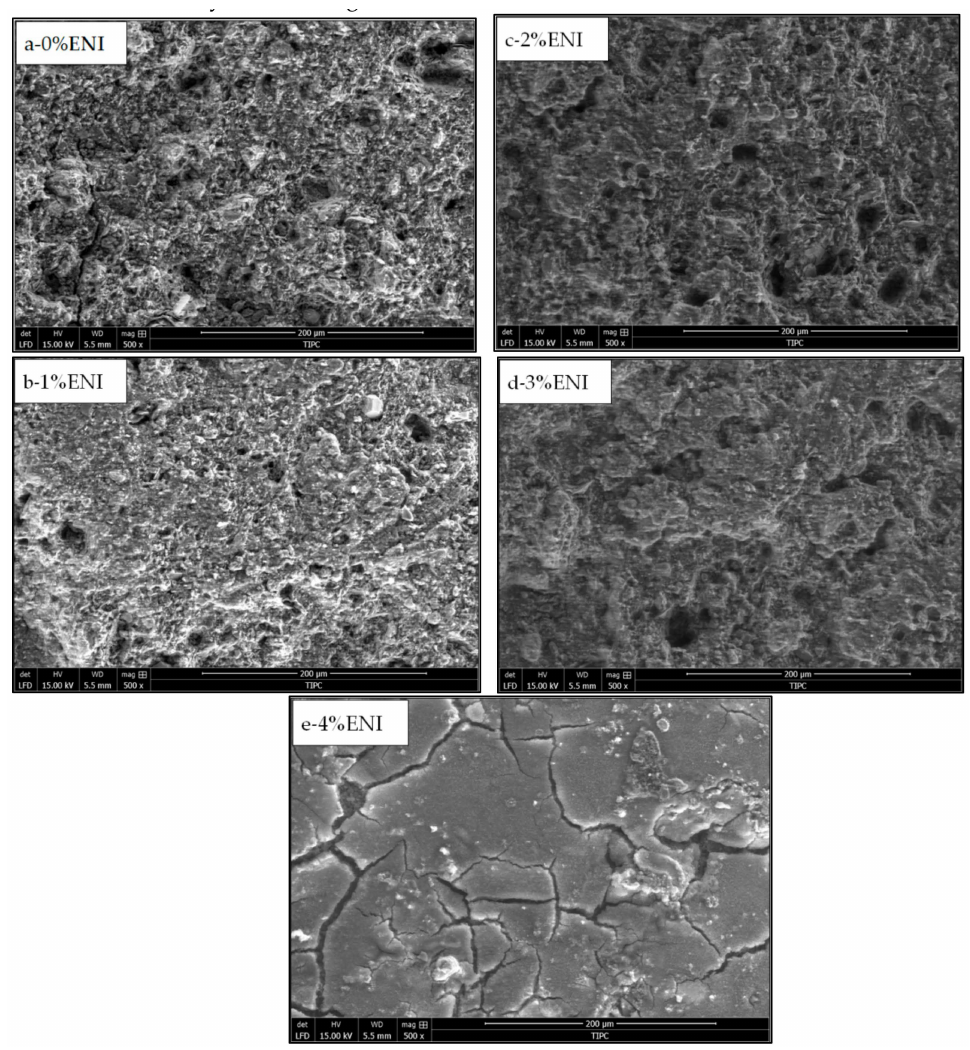
Figure 4. Microstructural diagram of shale pores. ( a ) 1%ENI; ( b ) 1% ENI; ( c ) 2% ENI; ( d ) 3% ENI; ( e ) 4% ENI. Table 2. Statistical table of information on shale pore